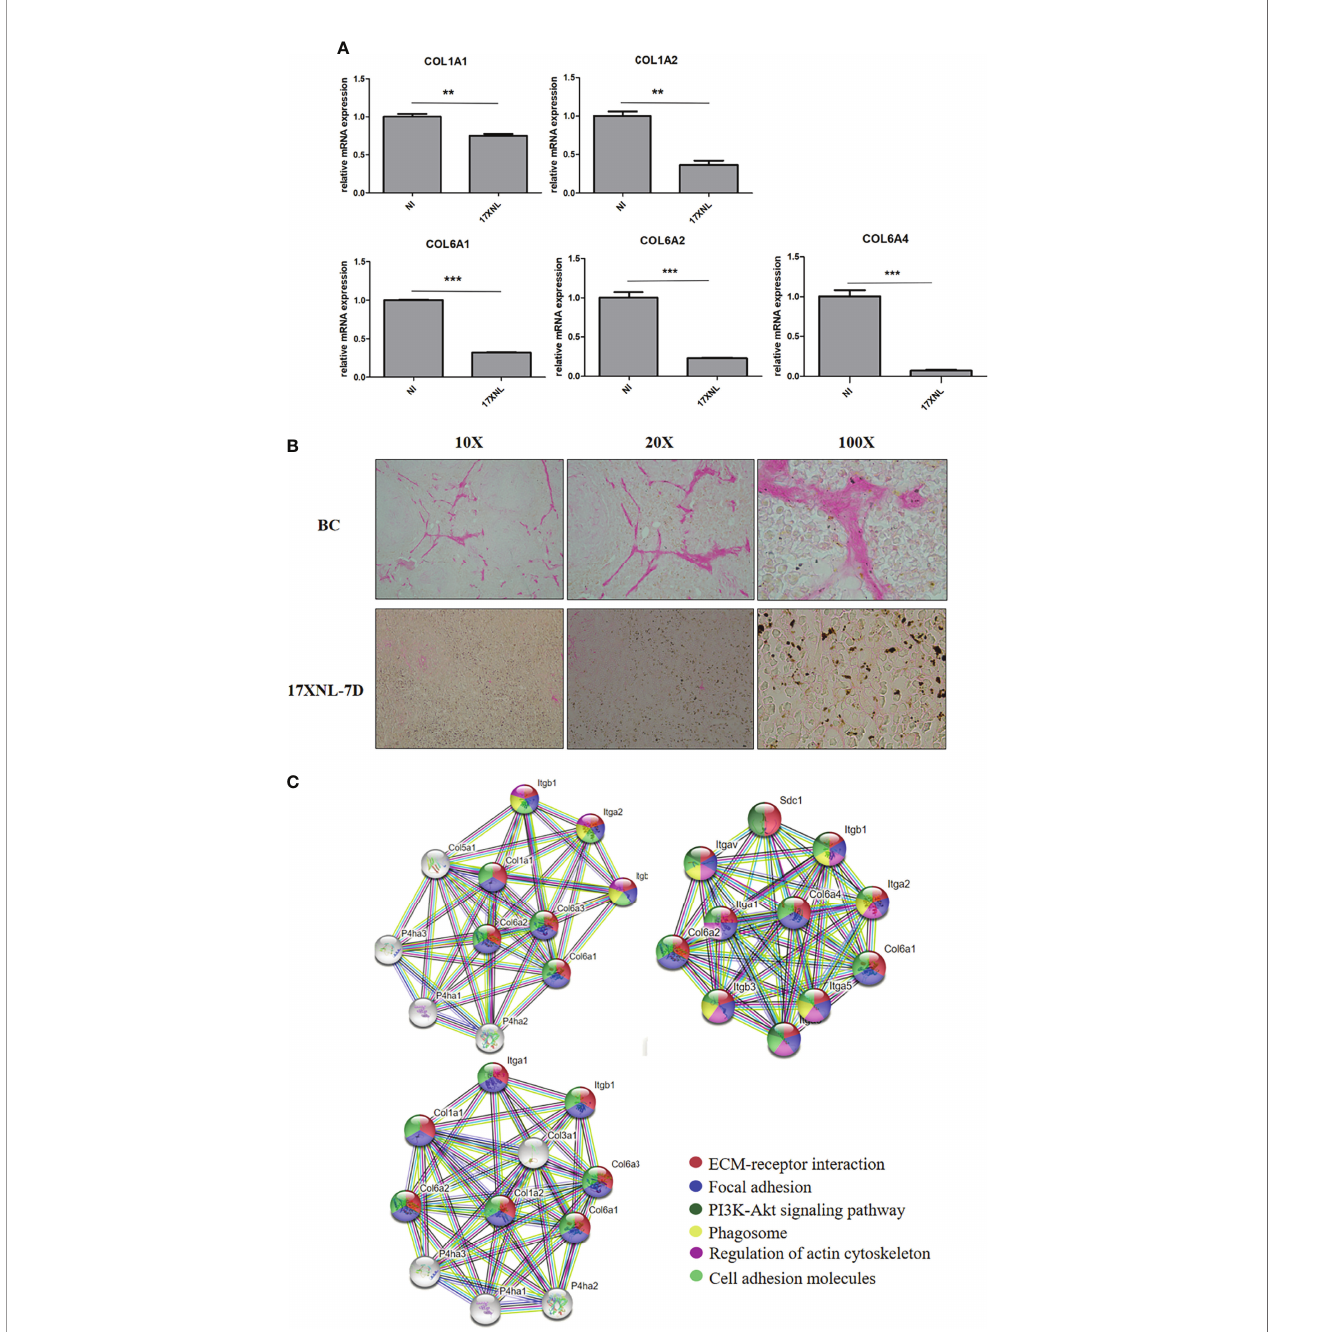
FIGURE 5 | Collagen levels in spleens of P. yoelii 17XNL-infected mice. (A) 200 m L saline containing 1 × 10 5 iRBCs was intraperitoneally injected into fi ve BALB/C mice, and the same amount of PBS was injected into the other fi ve mice. After 9 days, the mRNA expression levels of collagen in spleens of the two groups were determined and compared. NI, non-infected mice spleen. 17XNL, P. yoelli 17XNL -infected mice spleen. (B) Spleen paraf fi n sections of untreated mice and the mice infected with P. yoelii 17XNL were prepared. After 1 h of sirius red staining, dehydrated, transparent and sealed, the staining of collagen I (red) in each group was observed under ordinary optical microscope. NI, non-infected mice spleen. 17XNL-7D, spleen of mice infected with P. yoelii 17XNL for 7 days. (C) Col6a1, Col6a2 and Col6a4 interaction networks were constructed in STRING. The edges between the nodes represent different sources of active interaction. KEGG pathway analysis was integrated into STRING, and the different colors of each node represented different pathways related to the protein. False discovery rates of all pathways were lower than 0.01, indicating that KEGG pathway analysis was signi fi cantly enriched. Statistical analyses were carried out by Student ’ s t-test. (** P < 0.01; *** P <